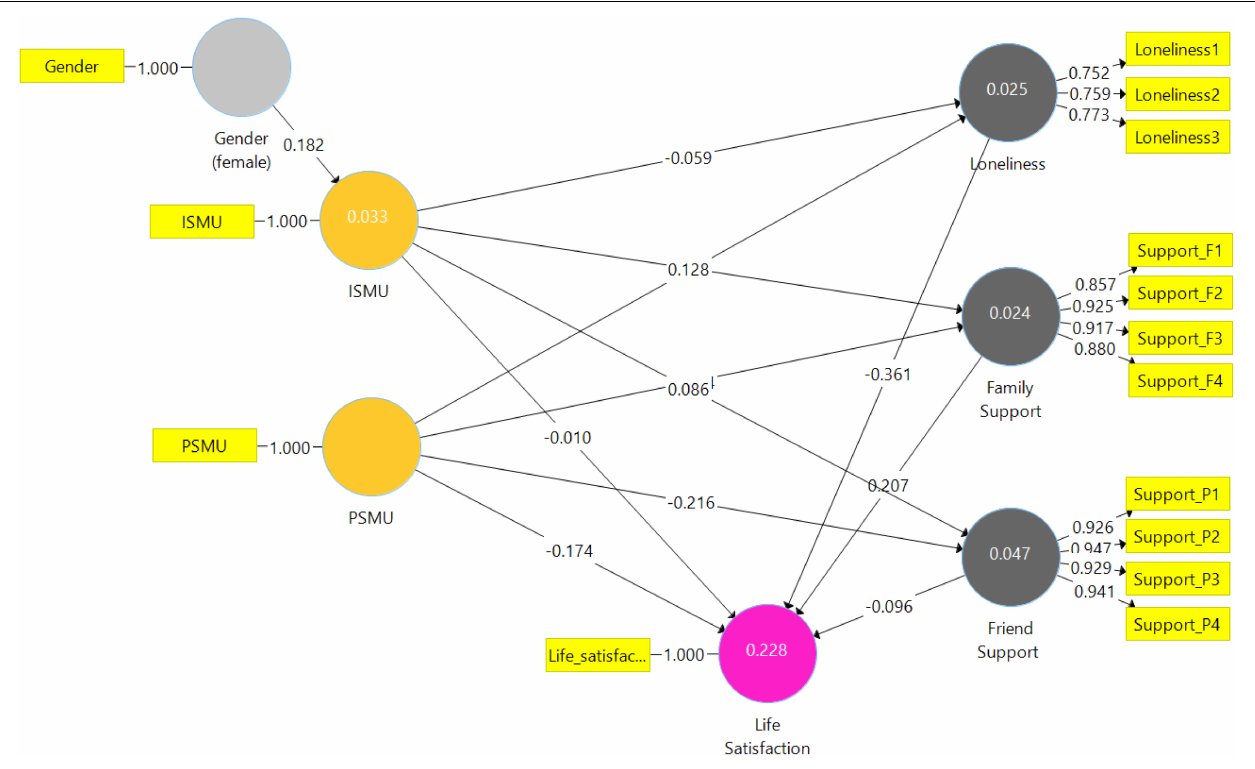
FIGURE 1 | Model 1 Analysis results of the examination of the research hypotheses by SmartPLS.